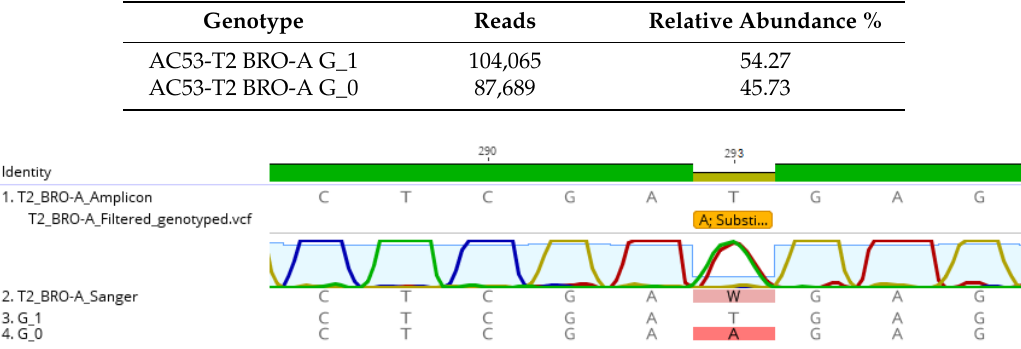
Figure 4. Comparison of the AC53-T2 reference sequence to the Sanger sequence and the two identified genotypes within HaSNPV-AC53-T2. The Sanger chromatogram at position 293 shows the two competing genotypes which were identified with MetaGaAP and validates relative abundance result.